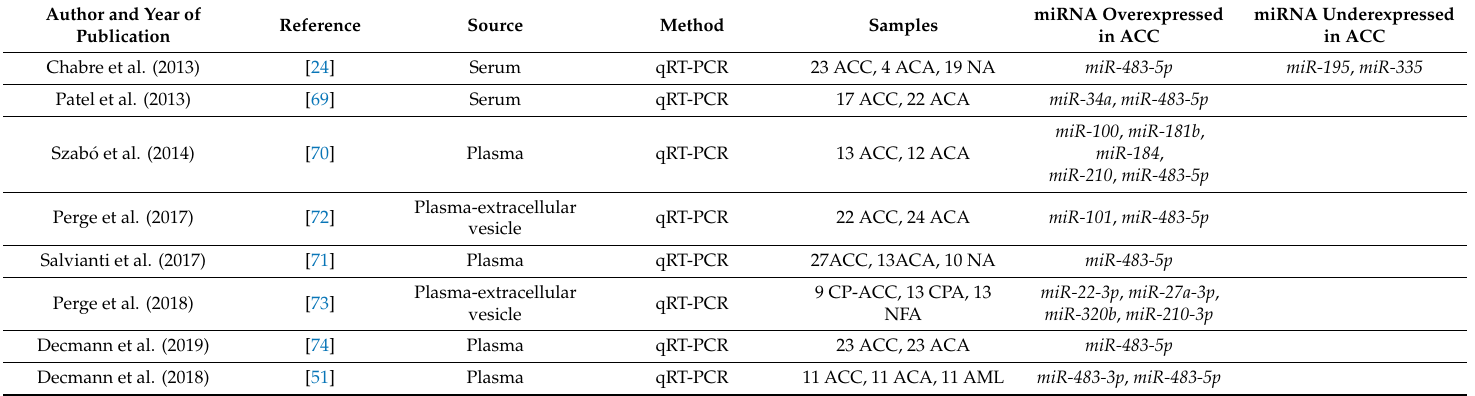
Table 3. Summary of studies reporting circulating miRNA expression findings in adrenocortical